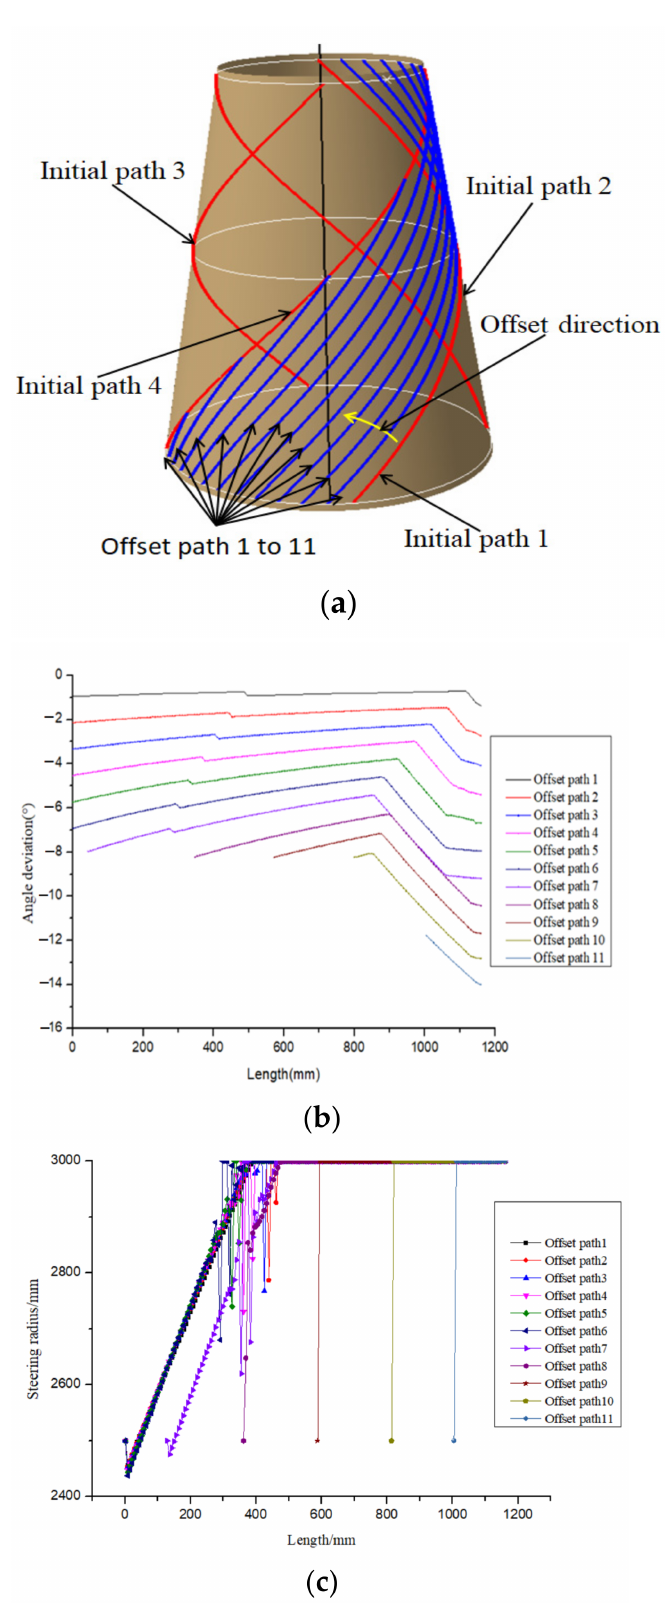
Figure 8. Equidistant offset paths based on partition and its manufacturability. ( a ) Equidistant offset paths based on partition. ( b ) Angular deviation of each offset path. ( c ) Steering radius of each offset